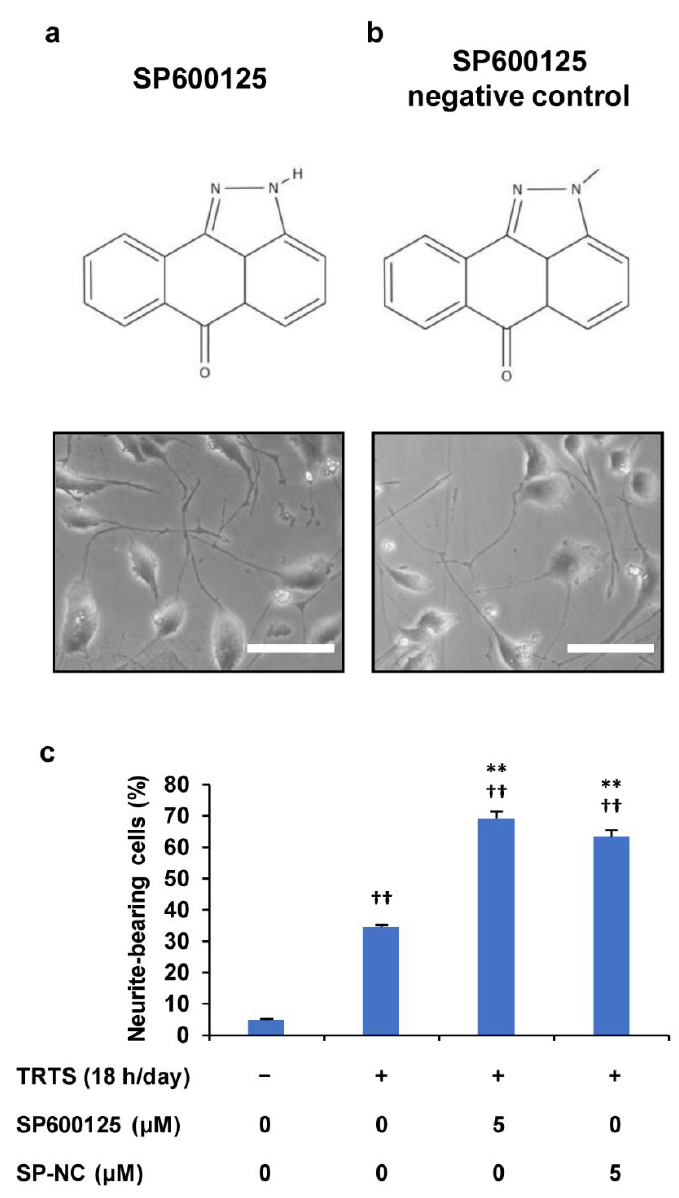
Figure 7. Effect of SP600125 negative control (SP-NC) on TRTS-mediated neuritogenesis in PC12-P1F1 cells. PC12-P1F1 cells were pretreated with 0.5 µ M SP600125 and SP-NC, respectively, and then exposed to TRTS for 18 h per day for 7 days. ( a , b ) Chemical structures of SP600125 ( a ) and SP-NC ( b ) and representative phase-contrast images on day 7 of TRTS-treated PC12-P1F1 cells in the presence of each compound. Scale bars: 100 μm. ( c ) Percentage of neurite-bearing cells on day 7. The data represent the means ± standard deviation of three replicates. †† p < 0.01 vs. control; ** p < 0.01 vs. TRTS alone.